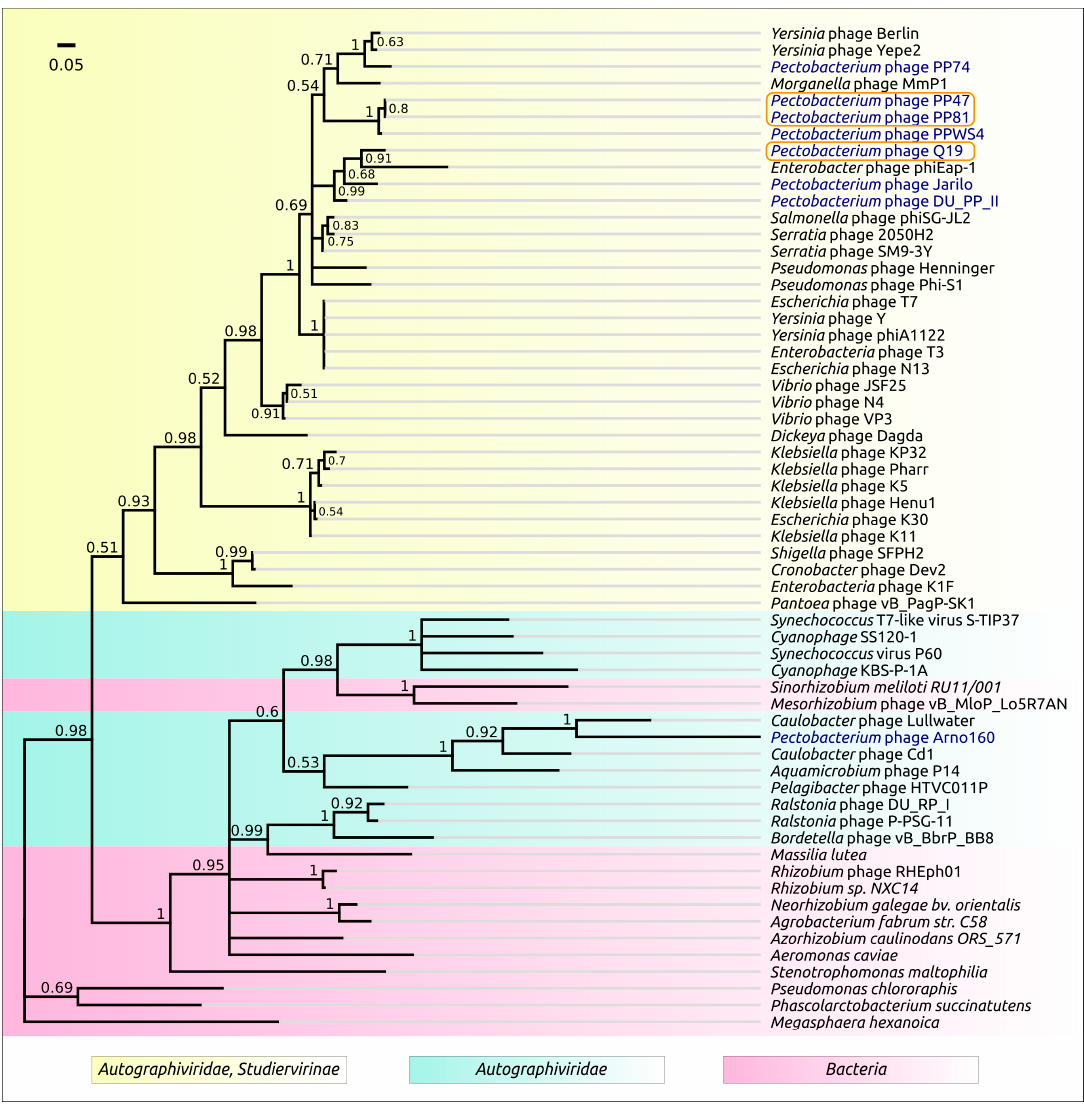
Figure 10. Phylogenetic tree obtained with MrBayes, based on amino acid sequences of the N-domain of tail fibre/tail spike proteins and homologous sequences obtained by a BLAST search of Genbank phage and bacterial databases. Bayesian posterior probabilities are indicated above their branch. The scale bar shows 0.05 estimated substitutions per site and the tree was rooted to Megasphaera hexanoica ; of 2,000,000 generations, 200 generations were sampled, with an average standard deviation of split frequencies of 0.011.